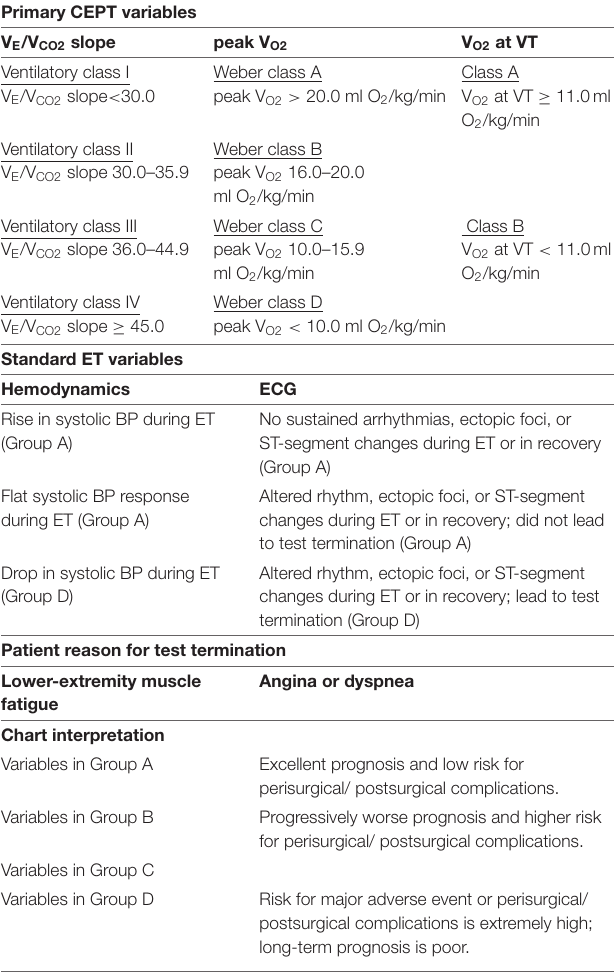
TABLE 1 | Pre-surgical assessment by cardiopulmonary exercise testing. Primary CEPT variables V E /V CO2 slope peak V